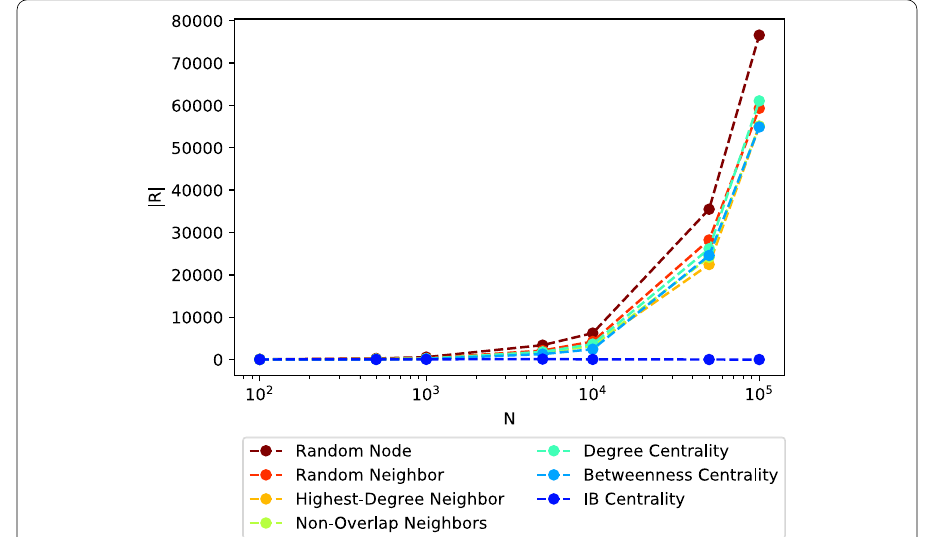
Fig. 8 Average number of infected nodes after convergence | R |, as a function of the network size N . The X-axis ( N ) is presented in log scale. IB Centrality maintains a low number of infected nodes, even for relatively large network